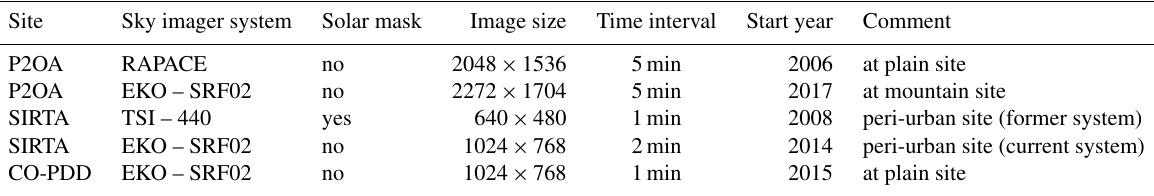
Table 1. List of sky imager systems within the ACTRIS-FR infrastructure and their characteristics. The list here only considers the systems for which the images are processed by ELIFAN for cloud cover